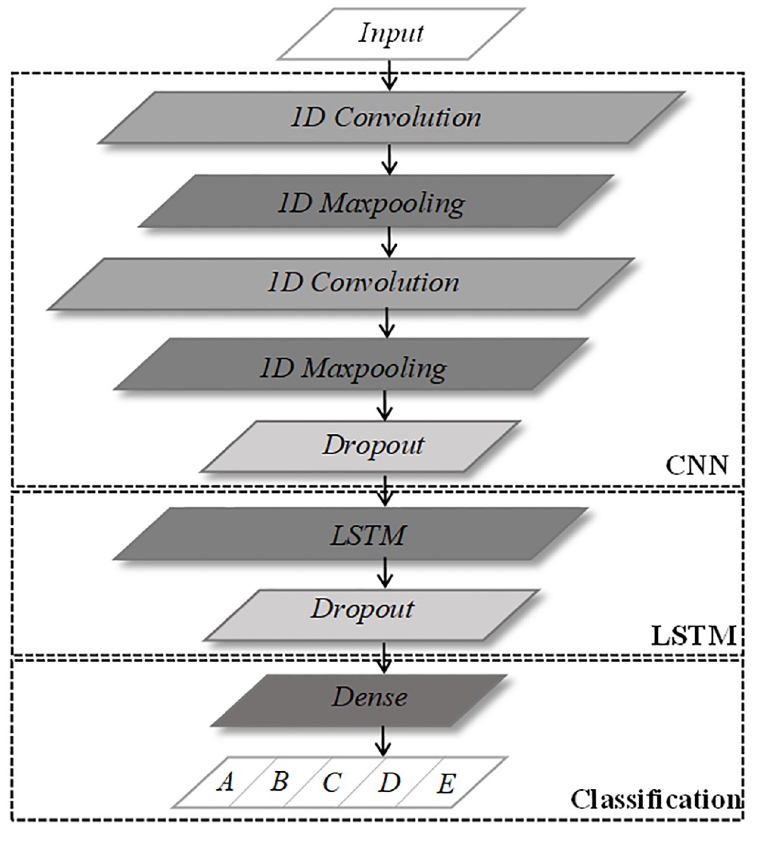
Fig 5. Joint network